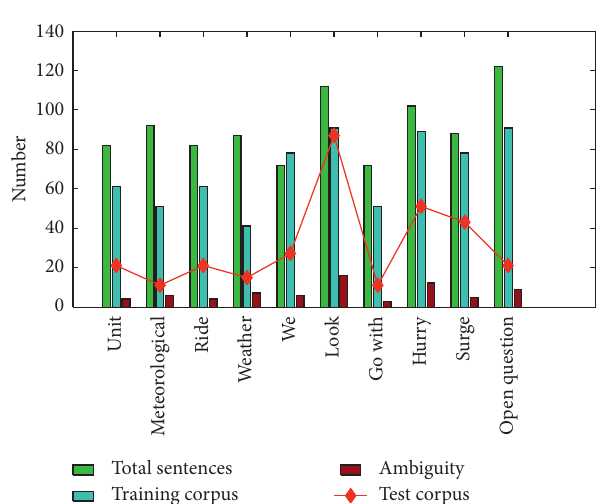
Figure 3: Detailed corpus statistics.